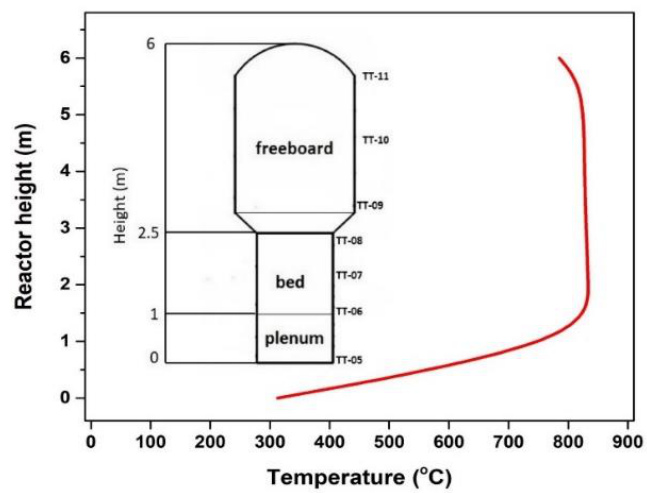
Figure 9. Temperature profile of the gasifier.